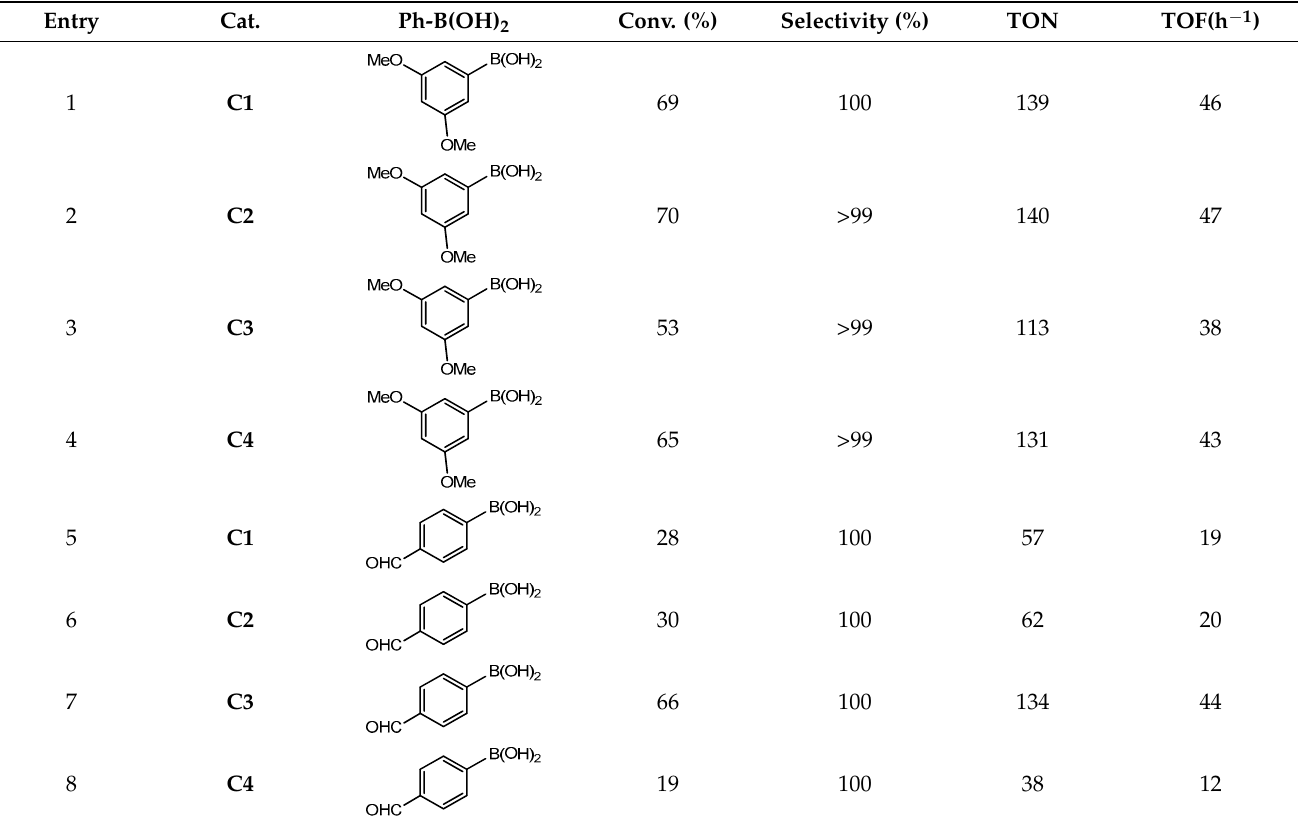
Table 12. Results obtained from Suzuki ‐ Miyaura coupling of bromobenzene with substituted phenylboronic acid under optimum conditions.